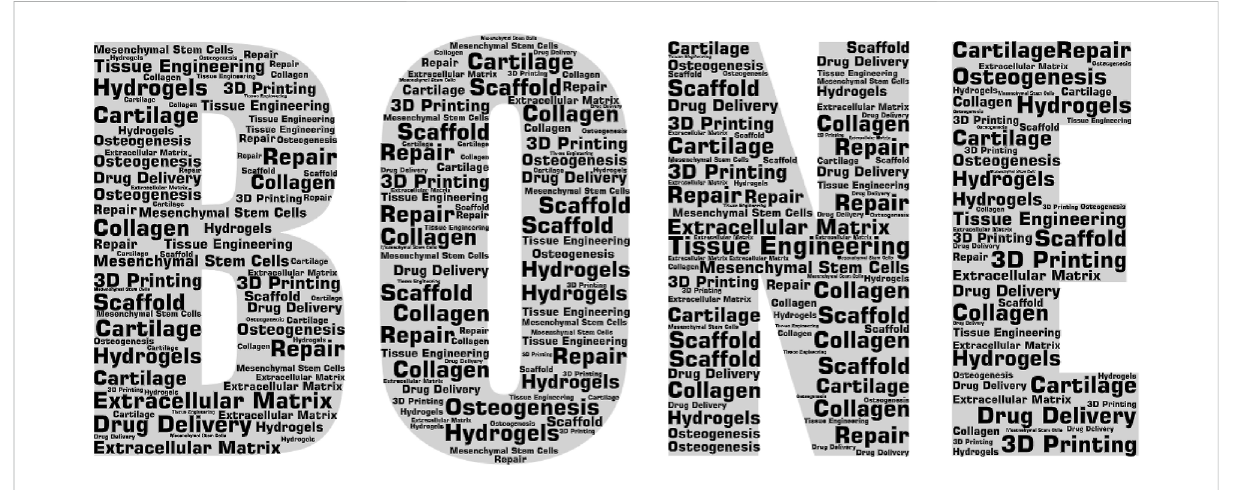
FIGURE 2 Wordcloud of the collection of literature keywords included in the